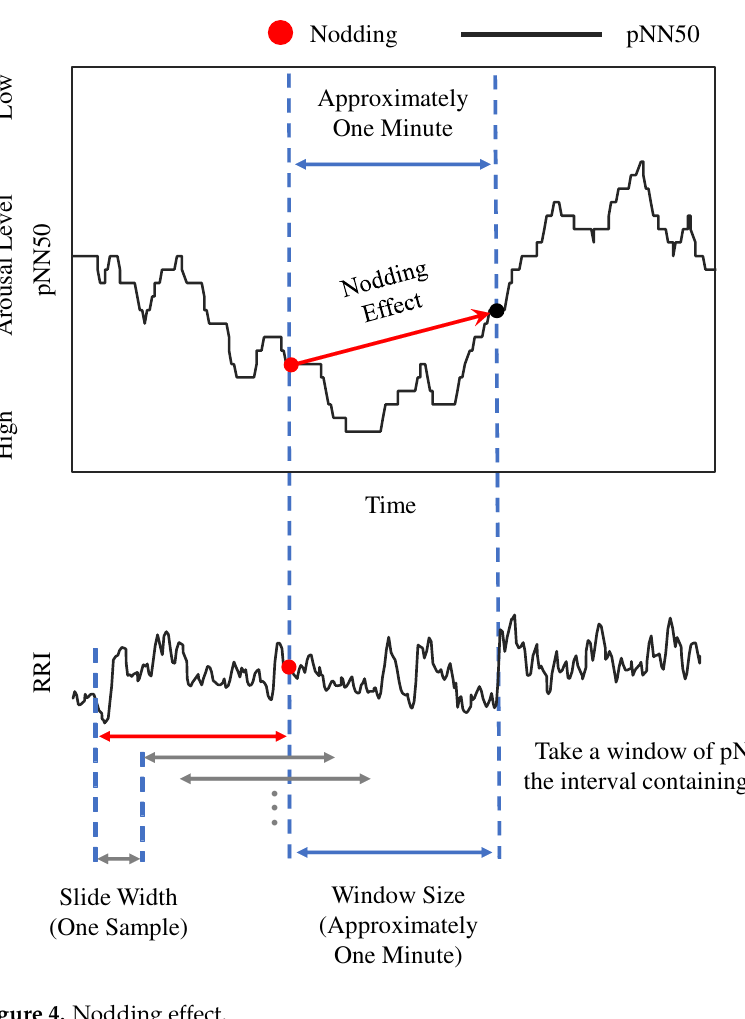
Figure 4. Nodding